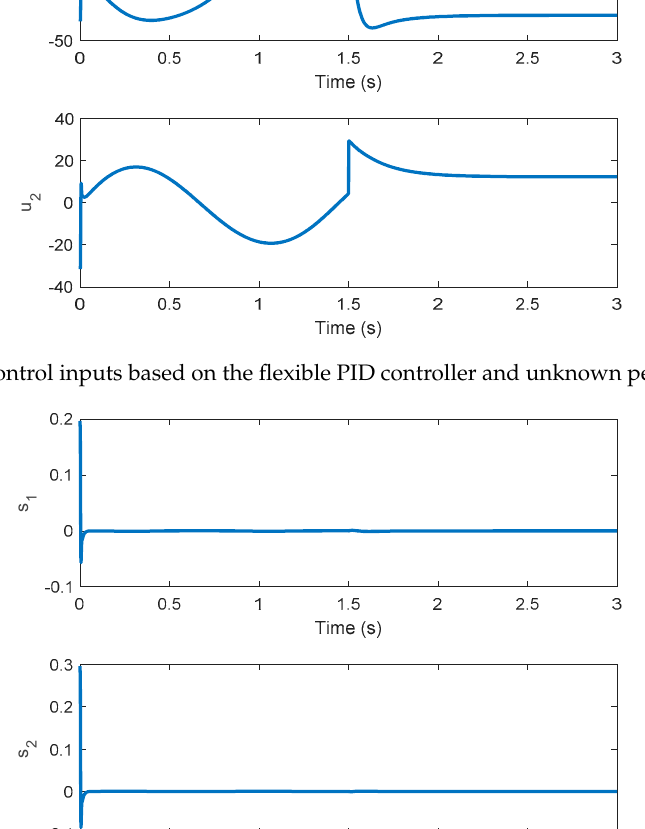
Figure 10. Sliding manifolds for the flexible PID controller with unknown perturbation.